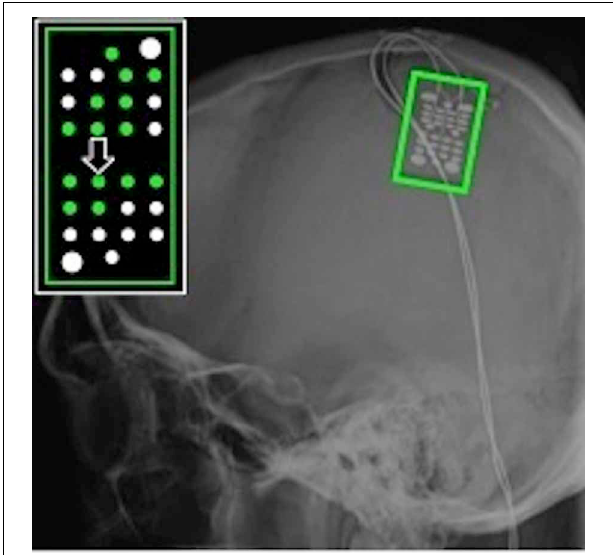
FIGURE 6 | ECoG grid location for Subject S, an individual with C4 complete spinal cord injury. The schematic inset shows electrodes that recorded a significant motor-related response during AO highlighted in green. The majority of these electrodes were located over primary somatosensory cortex. The large arrow marks the electrode whose data are shown in Figure 7 .